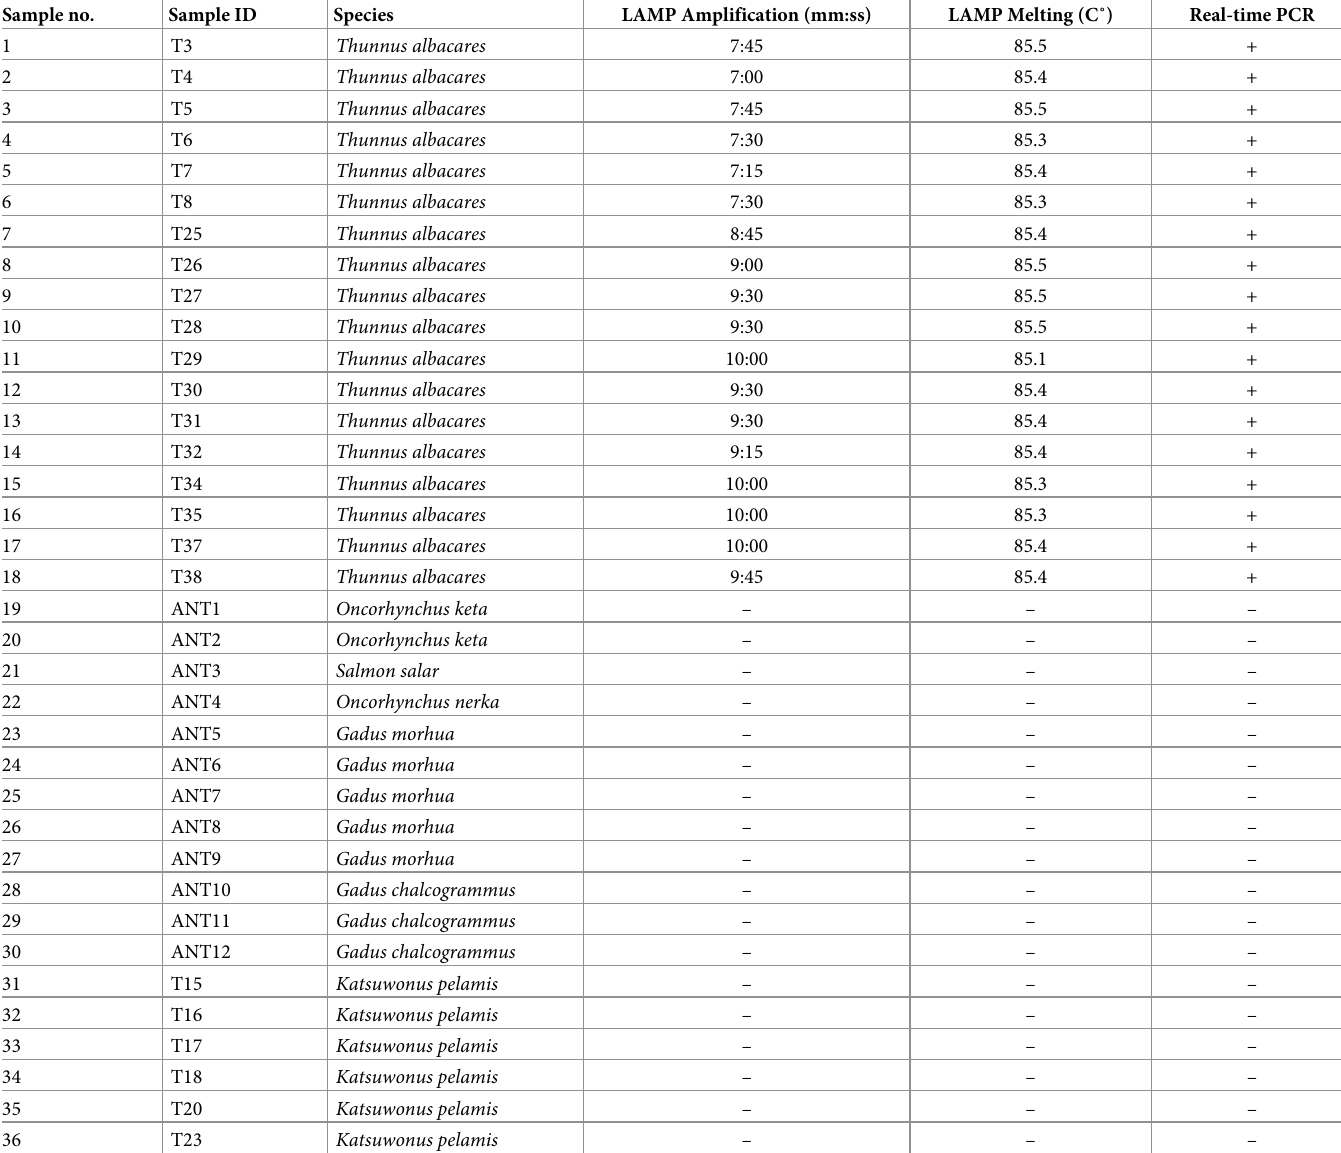
Table 2. Analytical specificity of the cytB -LAMP assay for target and non-target species compared to real-time PCR. Sample